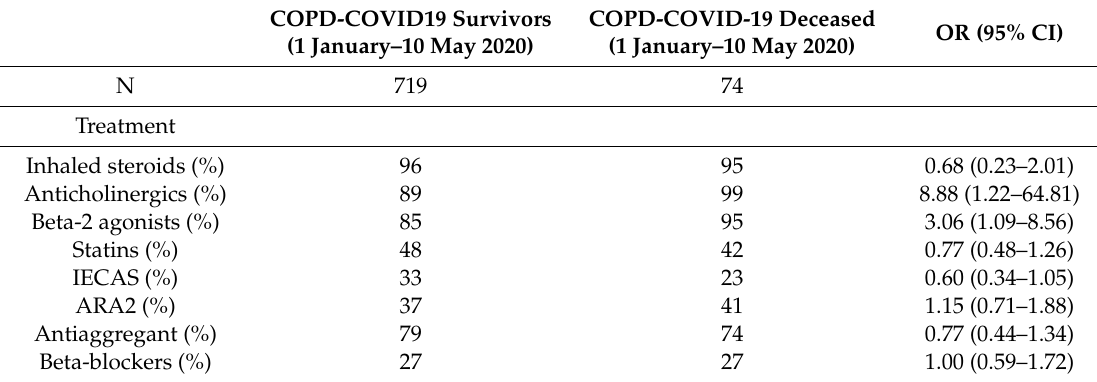
Table 4. Impact of treatments on the mortality of patients with COPD. COPD-COVID19